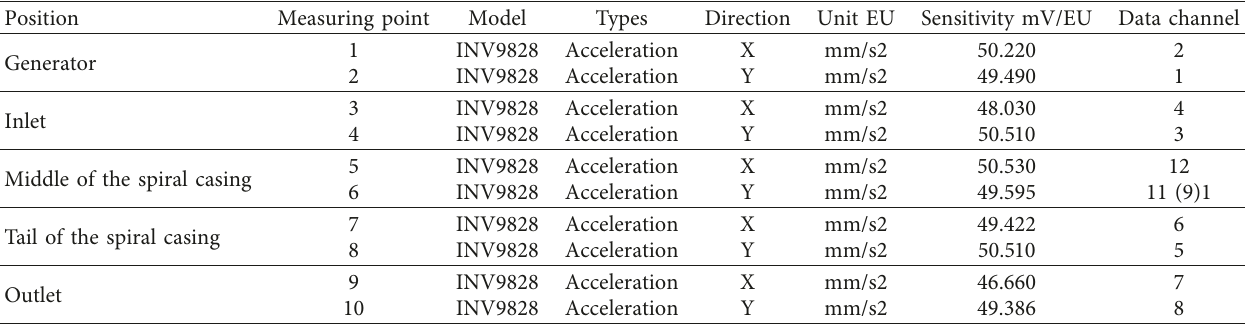
Table 1: Basic parameter table of the acceleration transducer.